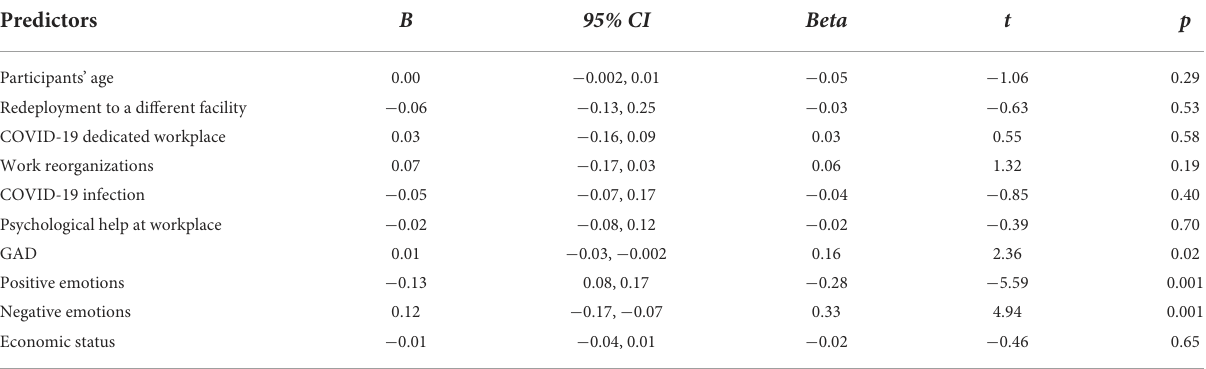
TABLE 7 Positive and negative emotions, GAD symptoms, and economic status as predictors of